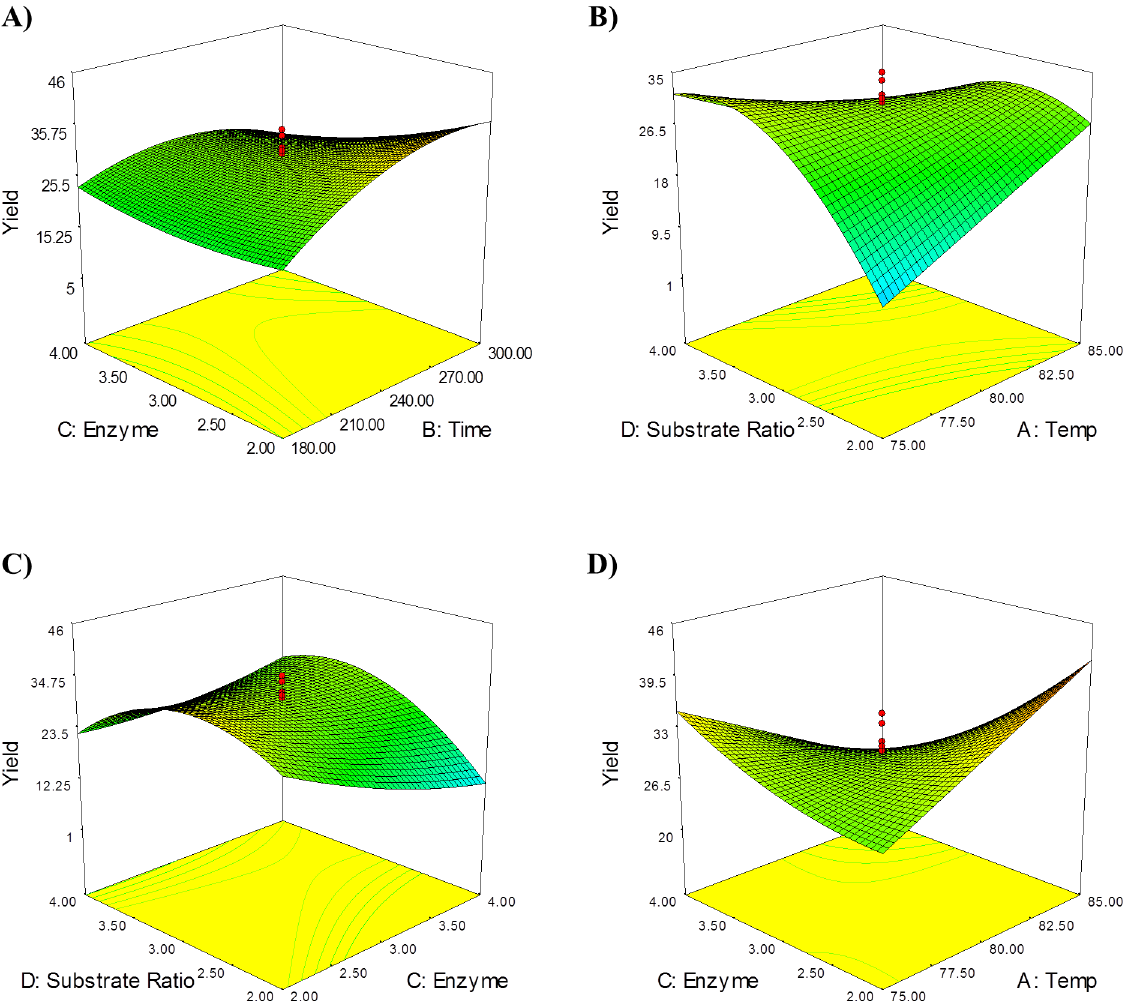
Fig 3. Three-dimensional response surface plots. (A) enzyme amount (%wt) versus reaction time (min), (B) substrate molar ratio (mmole) versus temperature (°C), (C) enzyme amount (%wt) versus substrate ratio (mmole), and (D) enzyme amount (%wt) versus reaction temperature (°C) on percentage yield as